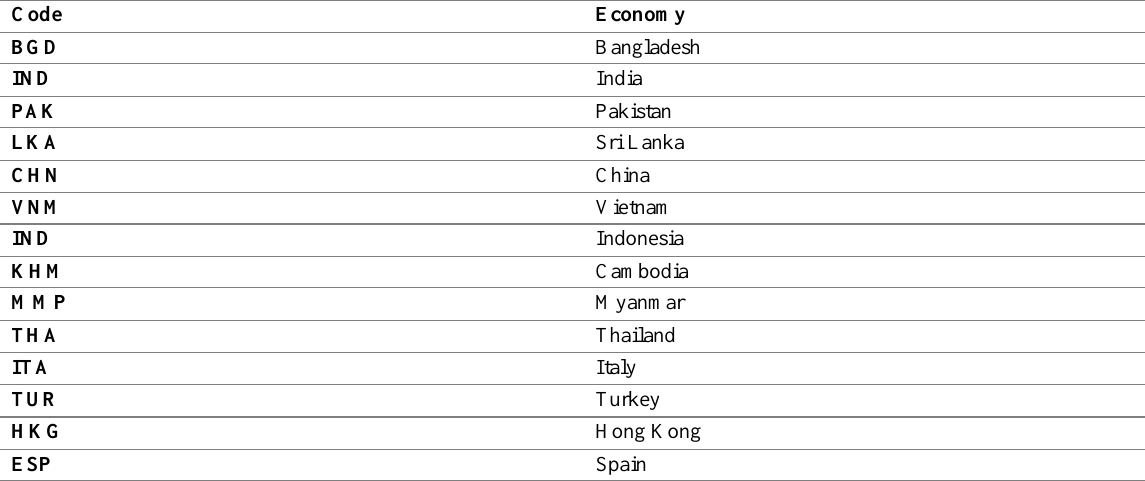
Table 3: Economy